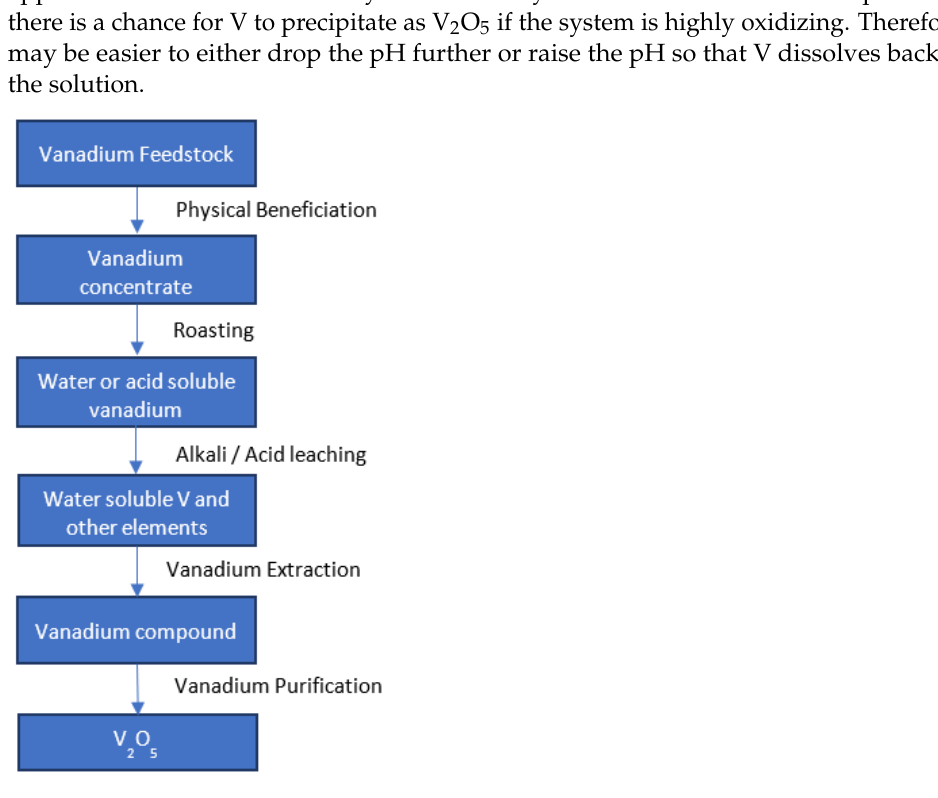
Figure 2. General Procedure for extraction of Vanadium from feedstock using a hydrometallurgical method.